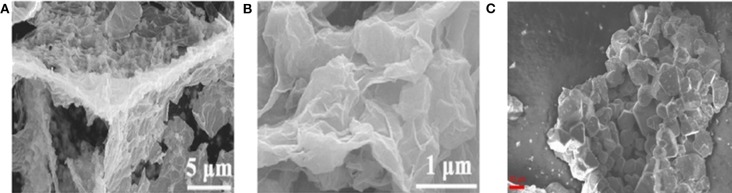
(A,B) SEM images of [ZnxCo1−xS QD@HCP]@rGO composites. Reproduced with permission from Chen Z. et al. (2017) Copyright 2017. Wiley-VCH. (C) SEM image of CuV2S4. Reproduced with permission from Krengel et al. (2017) Copyright 2017. American Chemical Society.